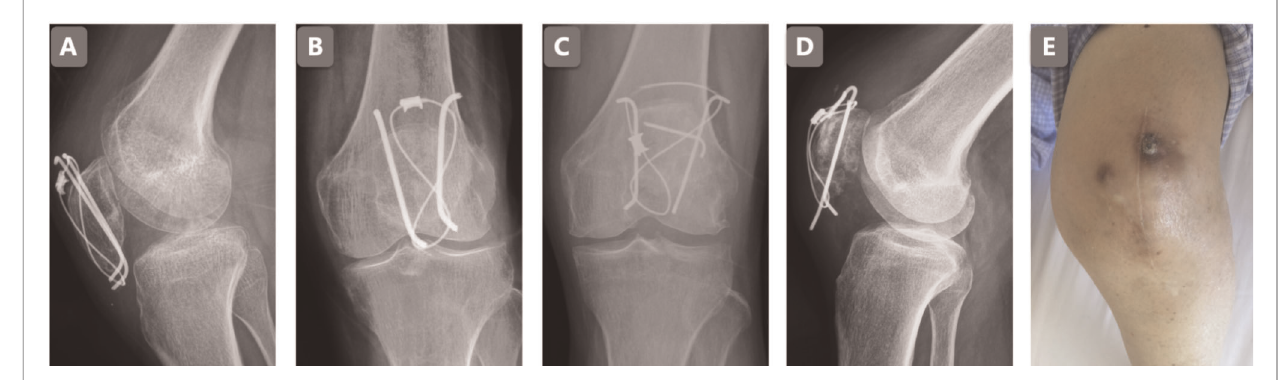
FIGURE 4 | Complications: simple rotation ( A ); cable unhooking ( B ); cable breakage ( C ); K-wire breakage ( D ); skin ulceration ( E